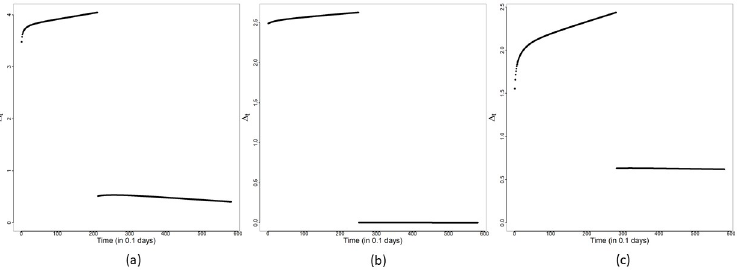
Fig 4. Constant rate submodel— Δ and (c) Sarawak.